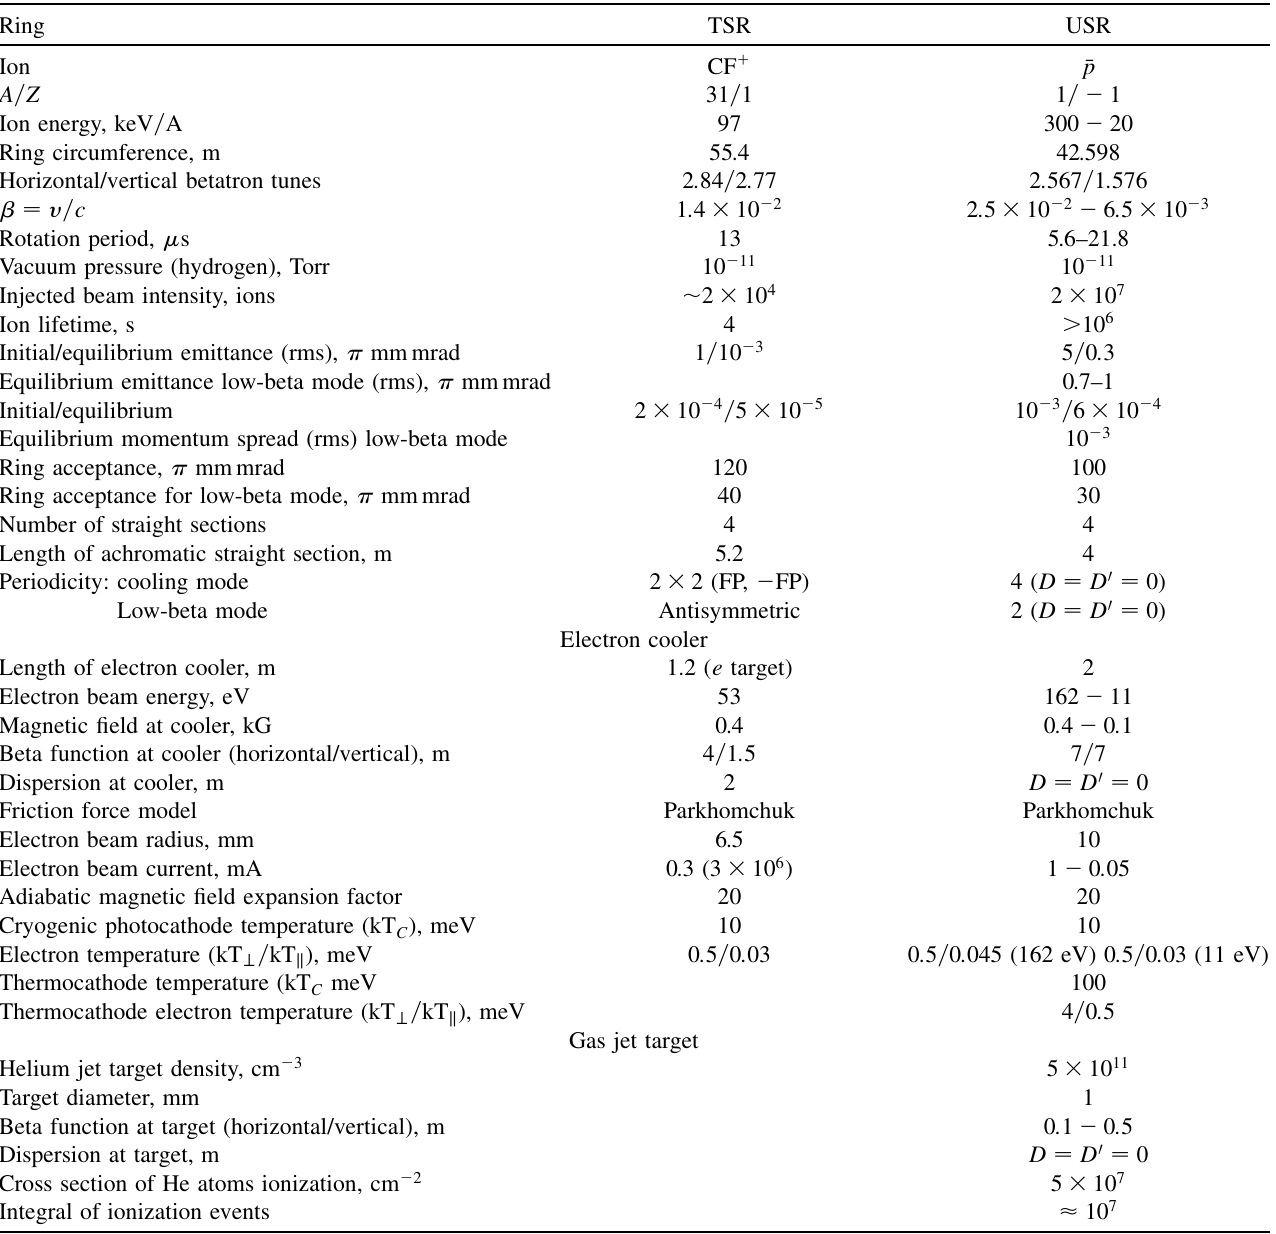
TABLE IV. Parameters during the TSR experiment and for the USR when operating with an internal